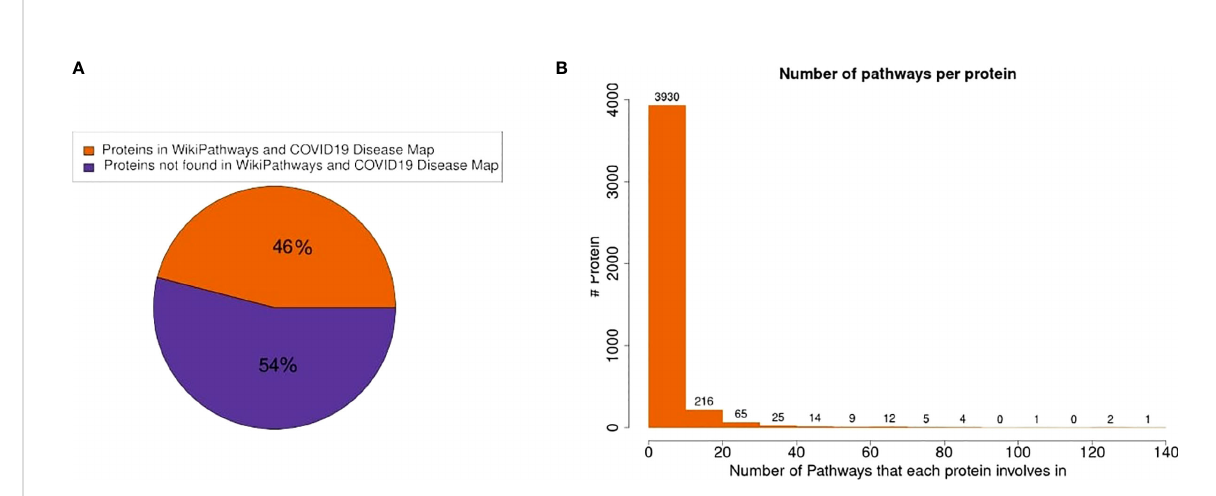
FIGURE 1 Protein presence in pathway models. (A) 46% of the measured proteins in the dataset were found in at least one pathway in the combined pathway collection. (B) The distribution of the number of pathways in which a protein participates shows that most proteins are only present in very few